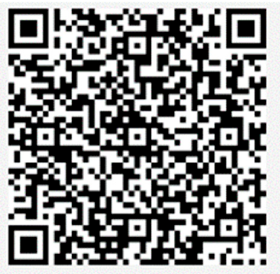
Figure A4. The QR-CODE of the eS.